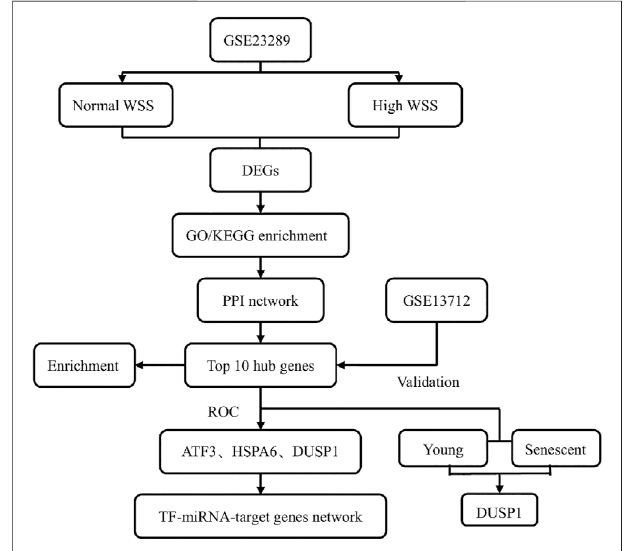
FIGURE 1 | Flow chart of this study